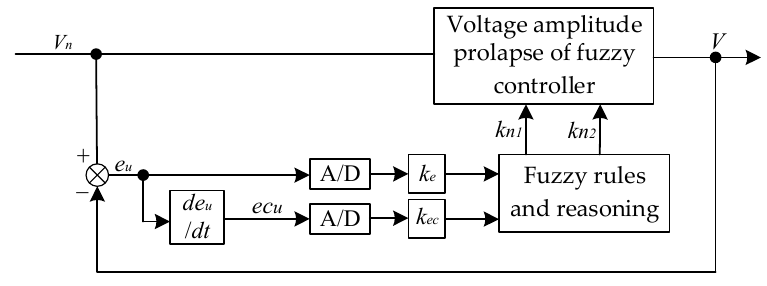
Figure 8. Voltage fuzzy droop control system diagram.